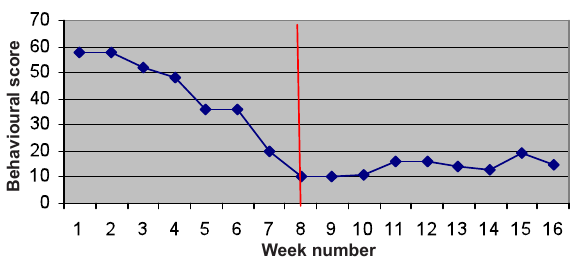
Figure 3. Behavioural scores of H . The weeks which show 3 the lowest score for H are between the 8 th and 10 th weeks In 3 its case the antler was cast off during the 8 th week (vertical red line). The behavioural score was 44±14 during the rut season; it became 12.6±3.13 during the velvet